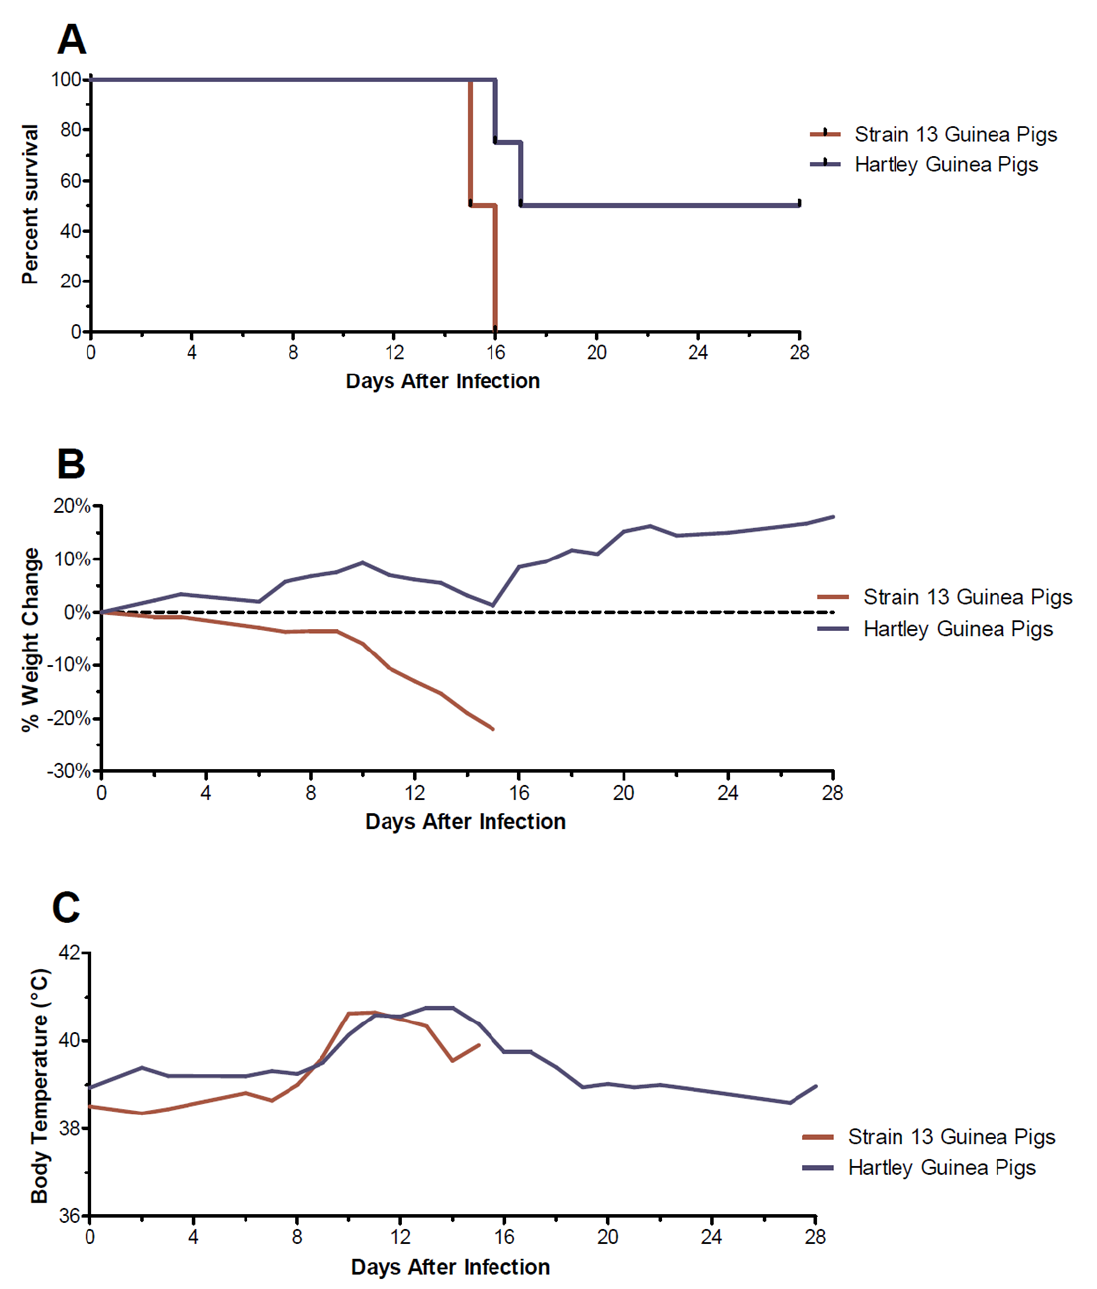
Figure 1. Comparison of clinical progression of a clade III Lassa virus isolate in strain 13 and Hartley guinea pigs. In an initial assessment of virulence, 6 strain 13 and 8 Hartley guinea pigs were inoculated with 1 × 10 5 median tissue culture infectious doses of a p1 clinical LASV isolate and observed daily for signs of disease. Shown are percent survival curves ( A ), average percent weight change ( B ), and average body temperatures ( C ).